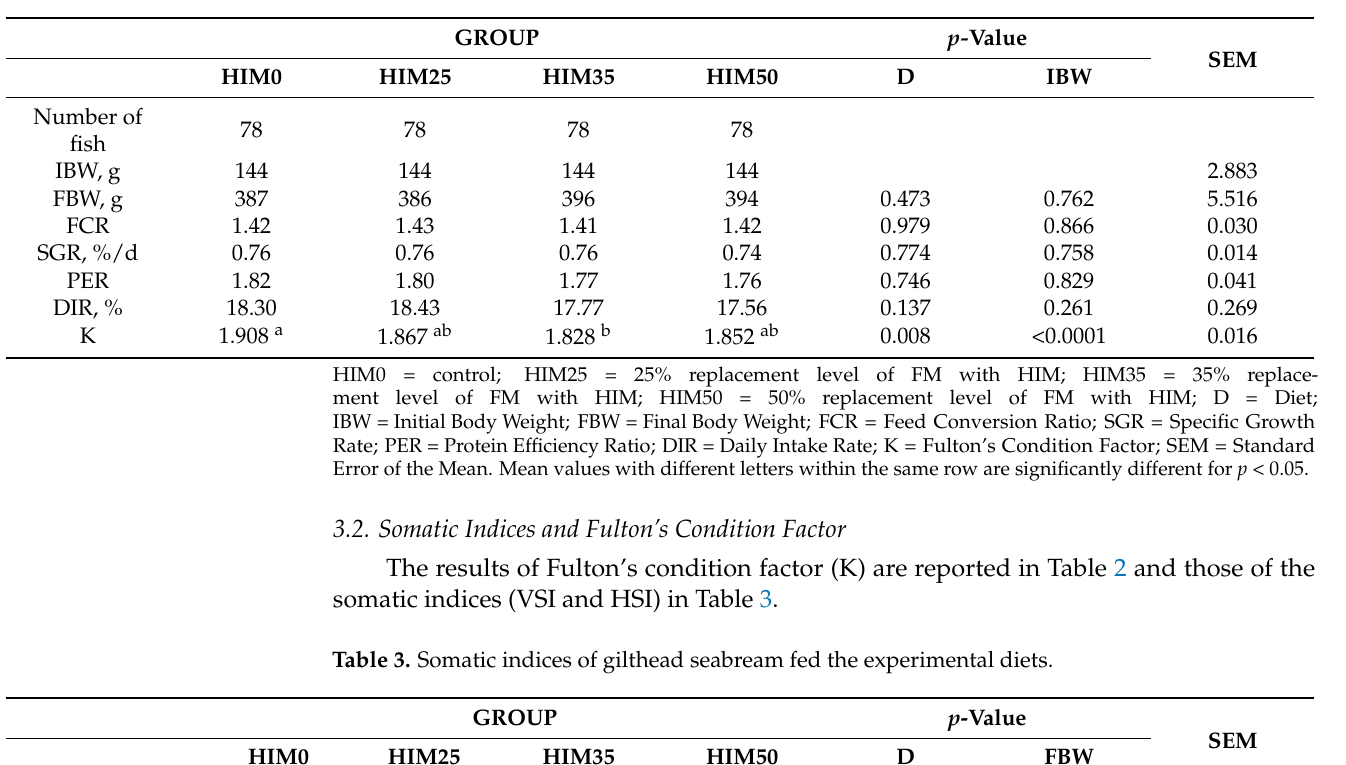
Table 2. Growth performance of gilthead seabream fed the experimental diets.